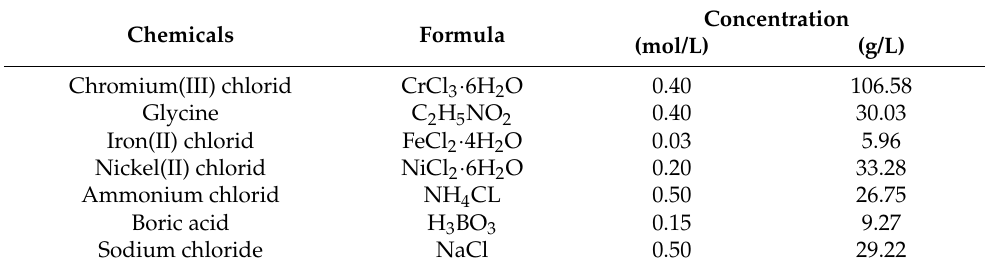
Table 1. Electrolyte